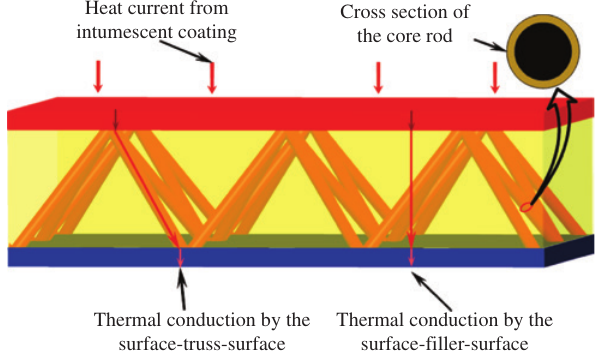
Figure 3: Schematic of the composite lattice sandwich structure and heat transfer